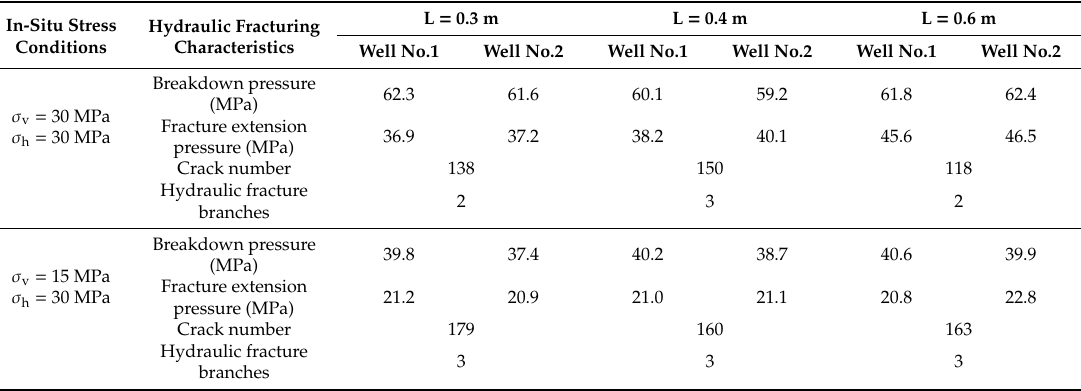
Table 4. Summary of the Fracturing Characteristics for the Two-Well Granite Model with Di ff erent Well Spacing under the Simultaneous